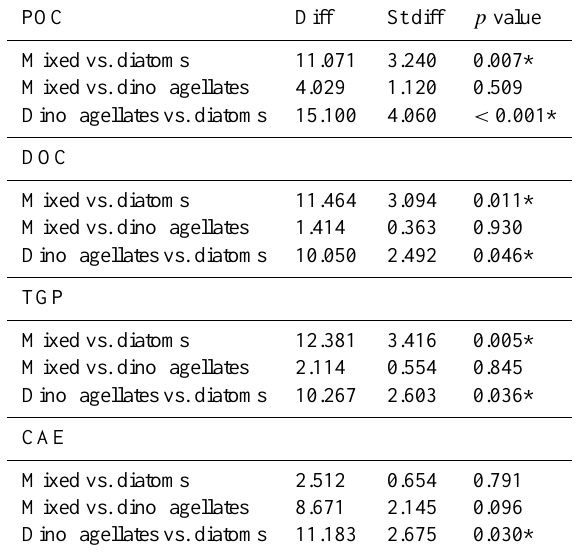
Table 4. Tukey’s post hoc tests of carbon parameters during station- ary growth phase. Only the statistically significant parameters from Table 2 were tested: particular organic carbon (POC), dissolved organic carbon (DOC), total gross production (TGP), and carbon assimilation efficiency (CAE). The phytoplankton community was categorized according to diatom dominance (diatoms), mixed com- munity (mixed) and dinoflagellate dominance (dinoflagellates). The stars (*) indicate statistically significant differences ( α = 0 . 05).